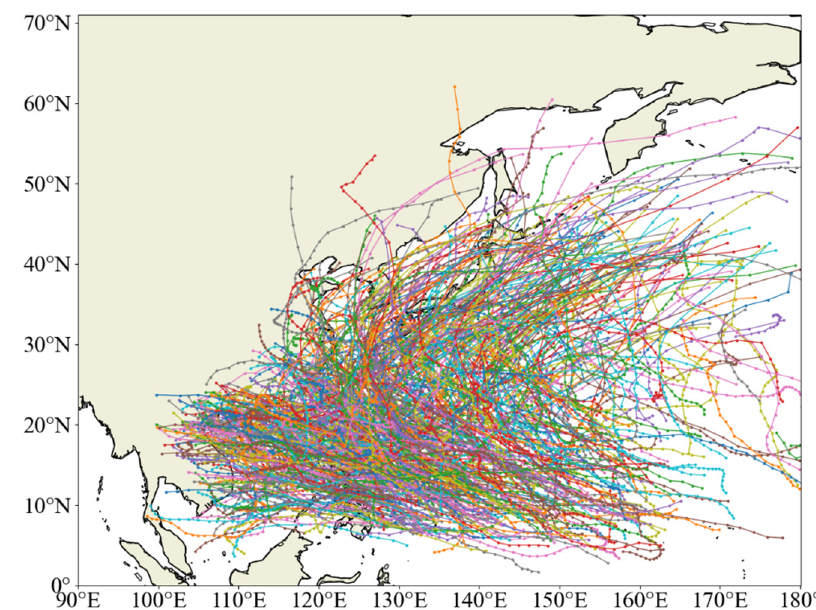
Figure 1. Typhoon tracks from 2001–2018 in the Western North Pacific. Different colored lines represent different typhoon tracks.